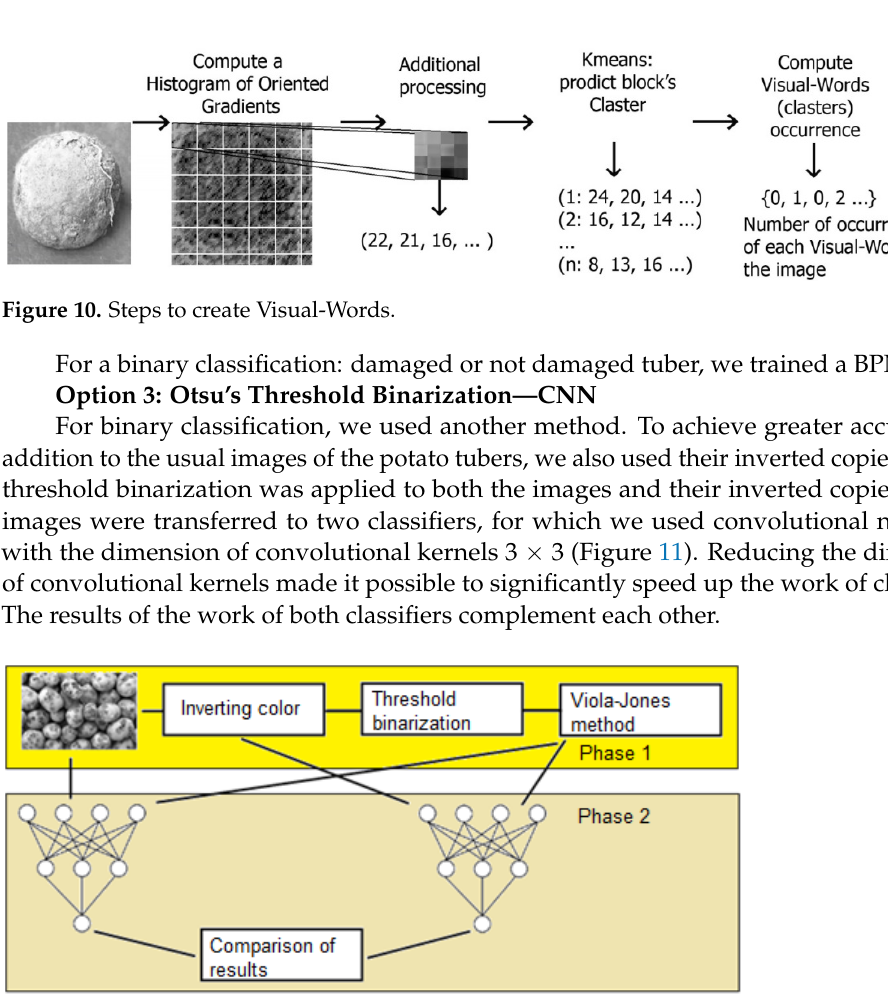
Figure 11. Generalized scheme of the algorithm.